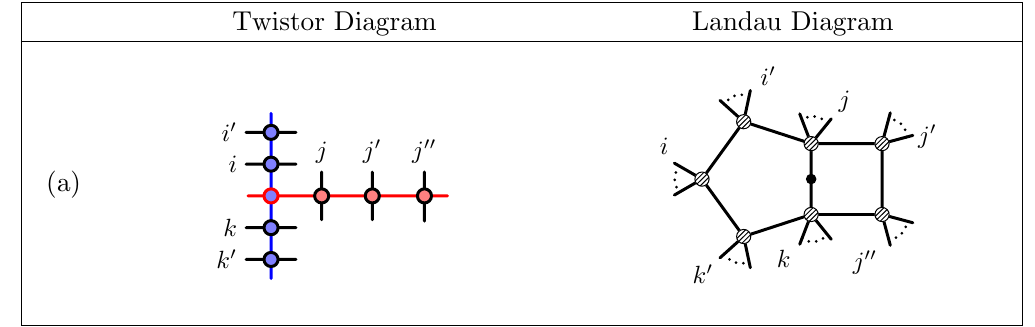
Table 5 . The twistor and Landau diagram describing a type of maximal codimension boundary of N k (cid:21) 4 MHV